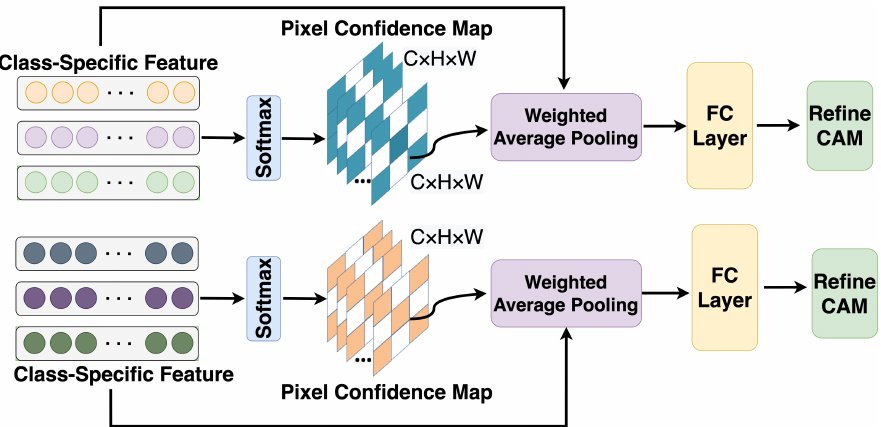
Figure 4. The schematic diagram of SLSC. The soft labels are adaptively assigned to each pixel with the softmax